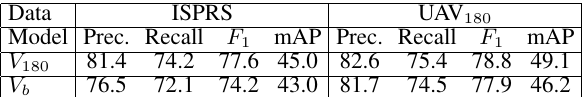
Table 1. Precision (Prec.), Recall, F 1 score and mAP for object detection on the two test datasets, achieved by the variant V 180 of our method and the baseline V b .